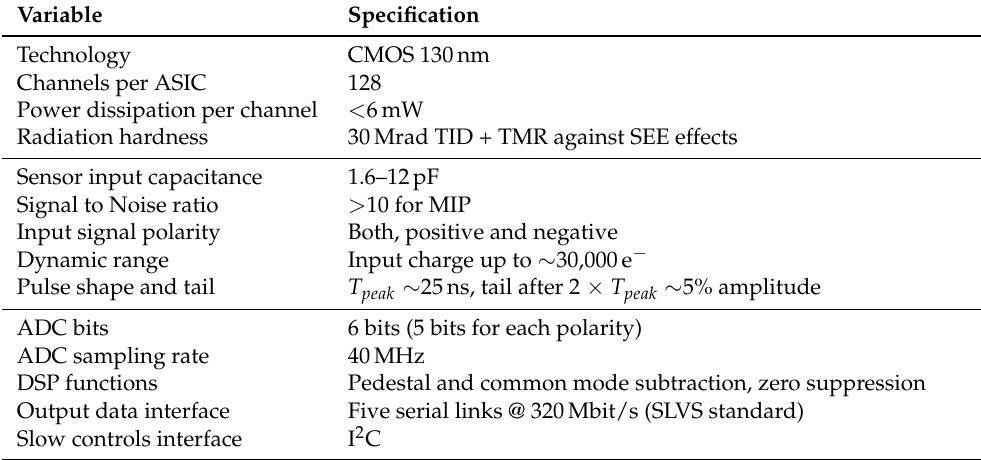
Table 1. Specifications of the SALT Application Specific Integrated Circuit